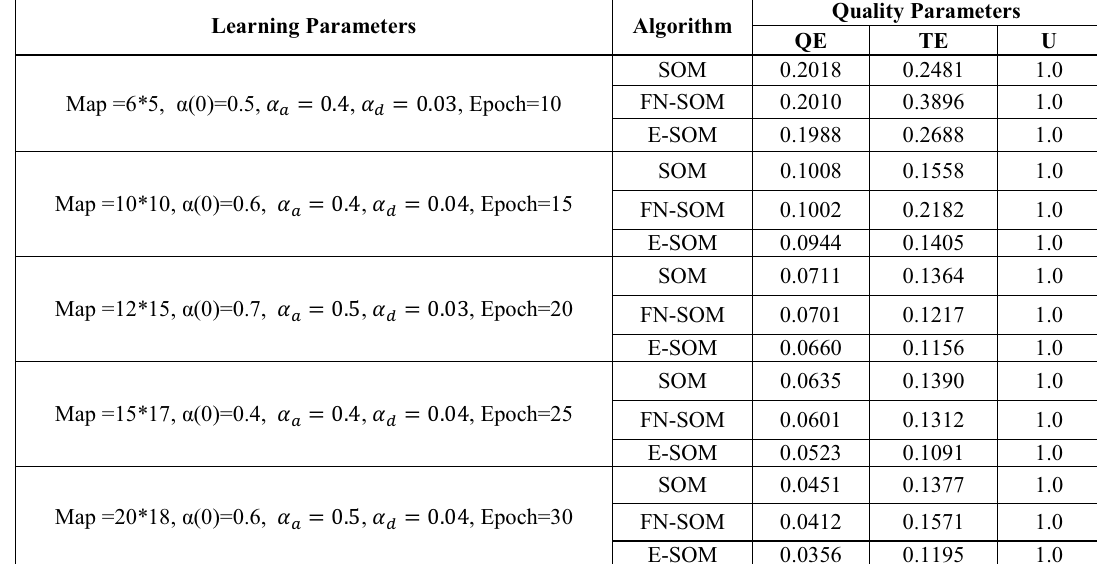
Table 1. Quantization error Qe, Topographic error Te and Neuron Utilization U for the Target dataset (Experiment 1).